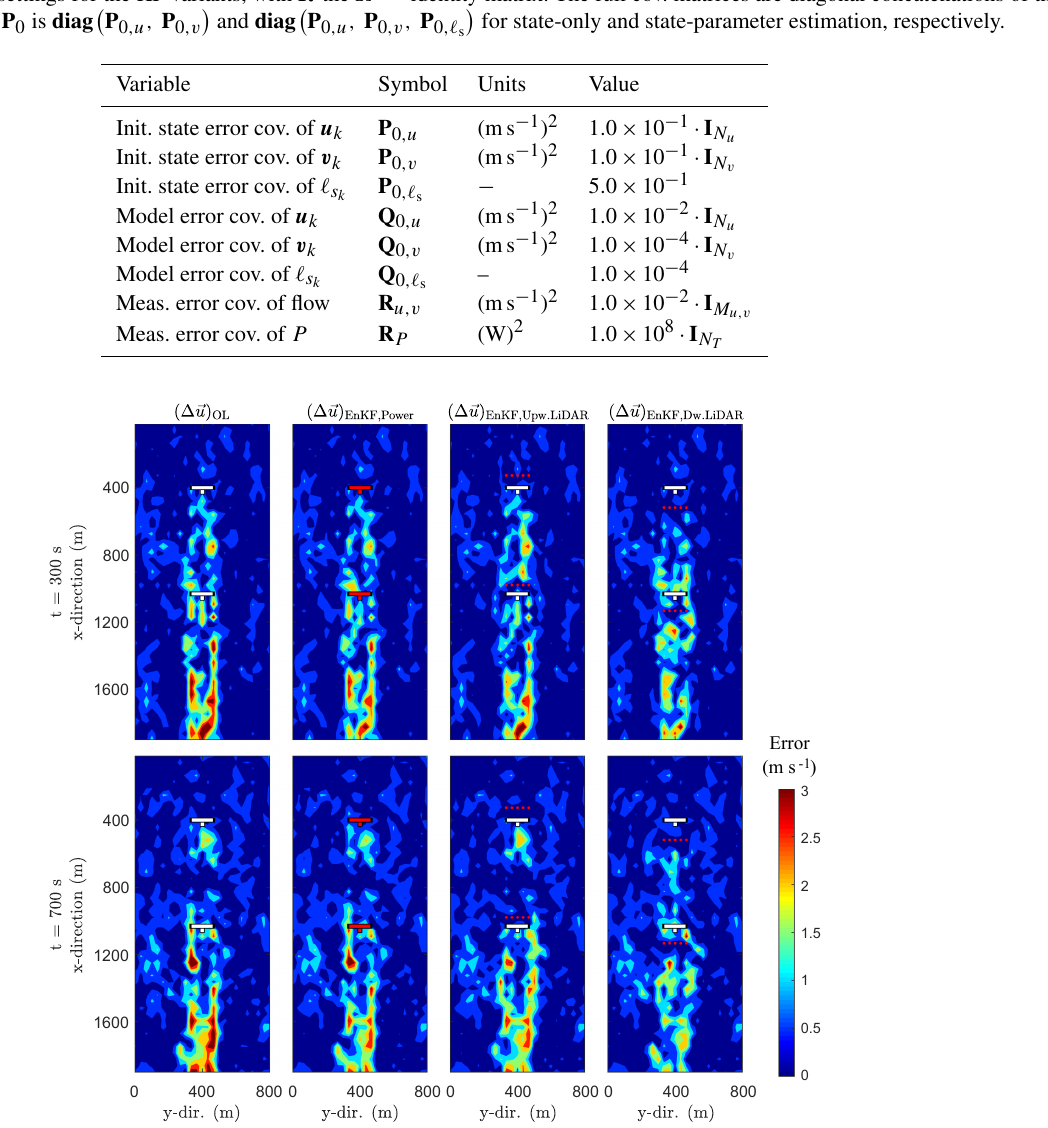
Figure 5. Comparison of absolute values of the estimation errors (in long. flow fields) for state-only estimation with the EnKF for various sensor configurations: using turbine power measurements, using flow measurements with a lidar system pointing upstream, and using flow measurements with a lidar system pointing downstream of the rotor. Here, ( (cid:49) u ) (cid:113) = | u (cid:113) − u SOWFA | . Here, wind flows from top to bottom. The sensors are depicted by red dots (flow meas.) or red turbines (power meas.), not to be confused with estimation